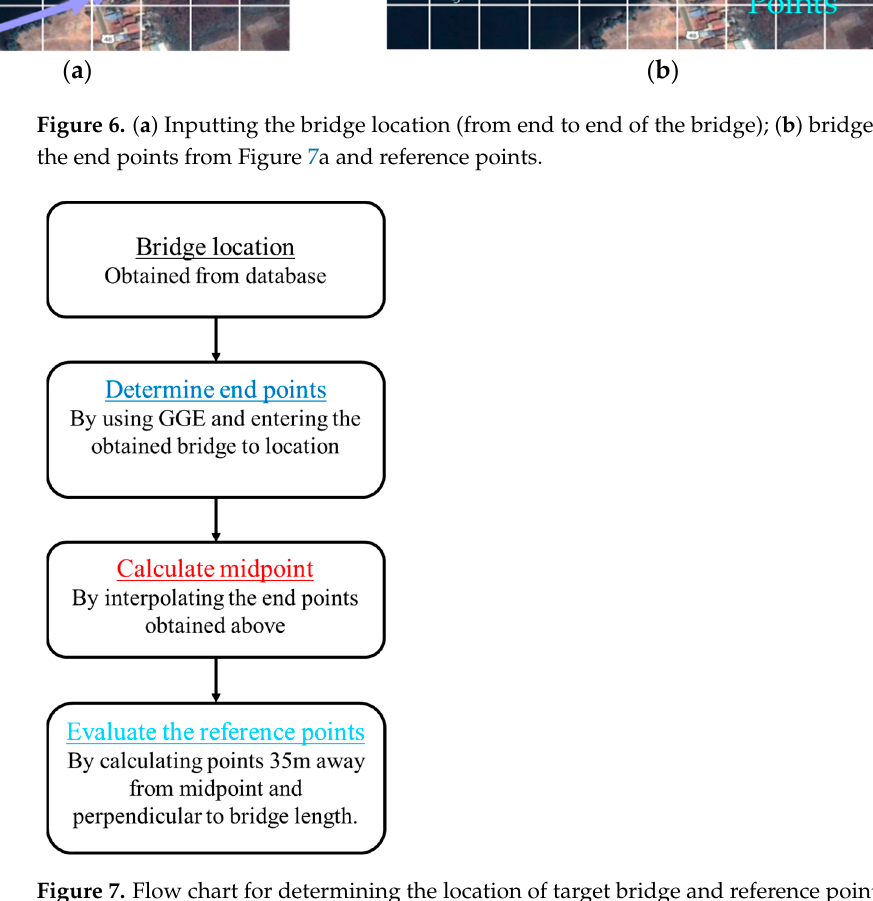
Figure 7. Flow chart for determining the location of target bridge and reference points. The NDWI index value, which is a function of green reflectance and near-infrared (NIR) reflectance is defined using Equation (1) [15]: NDWI = (Green − NIR)/(Green + NIR) (1) Green reflectance has a wavelength range of 0.52–0.60 μ m while NIR has a wave- length of 0.76–0.90 μ m. The plot in Figure 8a represents the NDWI values for the Sre Am- bel bridge (420 m long) over a number of years, with the NDWI of the target point plotted as a red line. The reference point values of NDWI are also plotted (in blue), with the upper value representing the reference point with the higher (maximum) index and the lower representing the lower (minimum) index; the range between the minimum and maximum NDWI values is shown as a blue shaded region. Variations in the NDWI value at reference points occurs mainly due to environmental factors that vary over time such as clouds, moisture condition, and vegetation variation. In the ideal case, if there is no construction activity at the target point during a certain time period, the NDWI value at the target point (red line) should lie within or very close to the NDWI range of the reference points (blue shaded region) for that period. After construction of a bridge, the change in reflectivity caused by the bridge deck should cause the NDWI value to suddenly change such that it lies outside the reference region. Figure 8b plots the difference between the NDWI value of the target point from that of the reference point value closer to the target point value. Observation of Figure 8b indicates that the NDWI year of construction of the Sre Ambel Bridge is 2008 even though the year predicted by visual analysis was 2007. ( a )